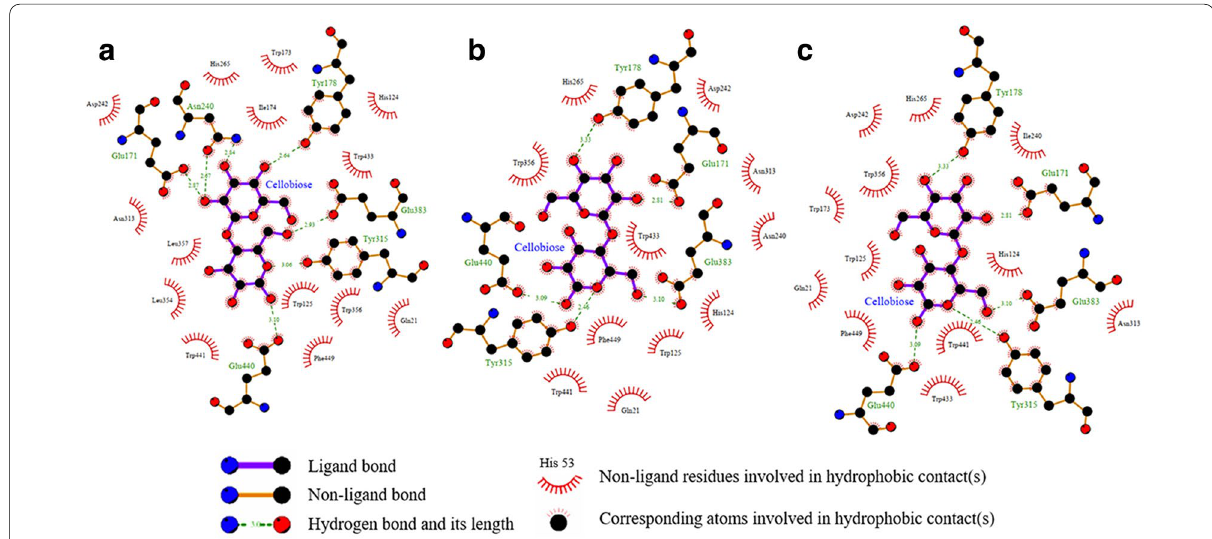
Fig. 4 The interaction profiles between Tr Cel1b ( a ), Tr Cel1b I177SI174SW173H ( b ) or Tr Cel1b N240I ( c ) and cellobiose analyzed by LigPlot,